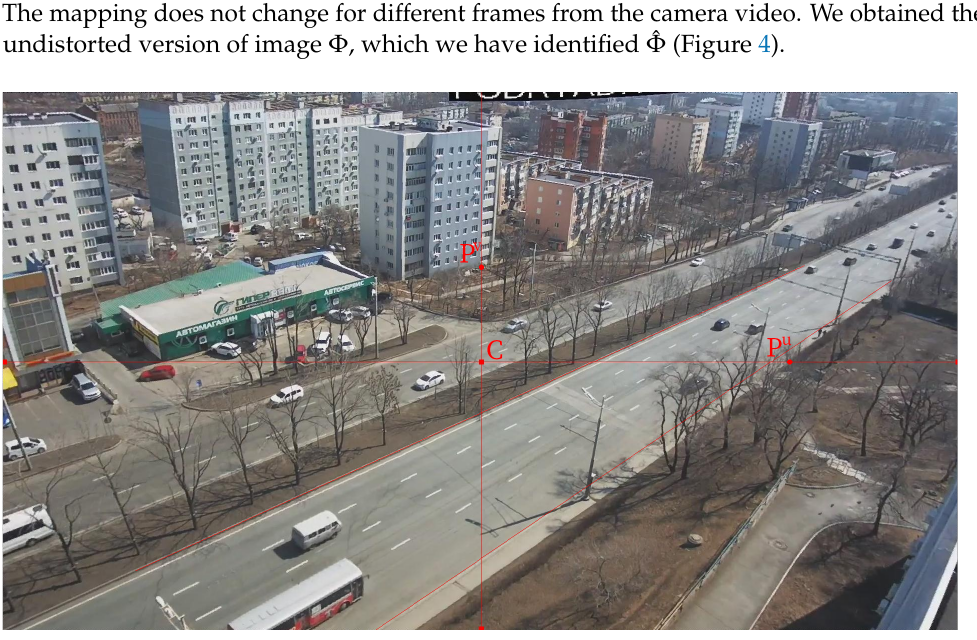
Figure 4. The image after compensation of radial distortion. Example 1, image ˆ Φ = Θ ( Φ )